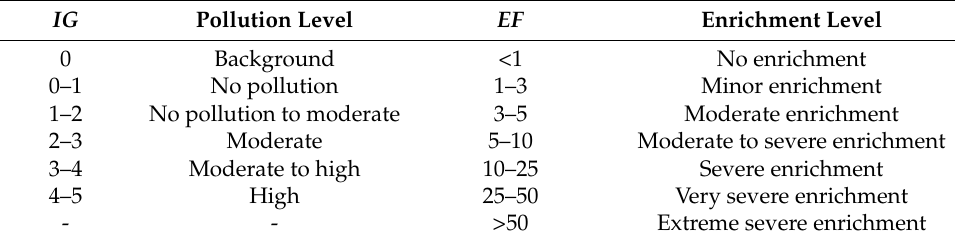
Table 3. Classes of IG and EF [27–30].